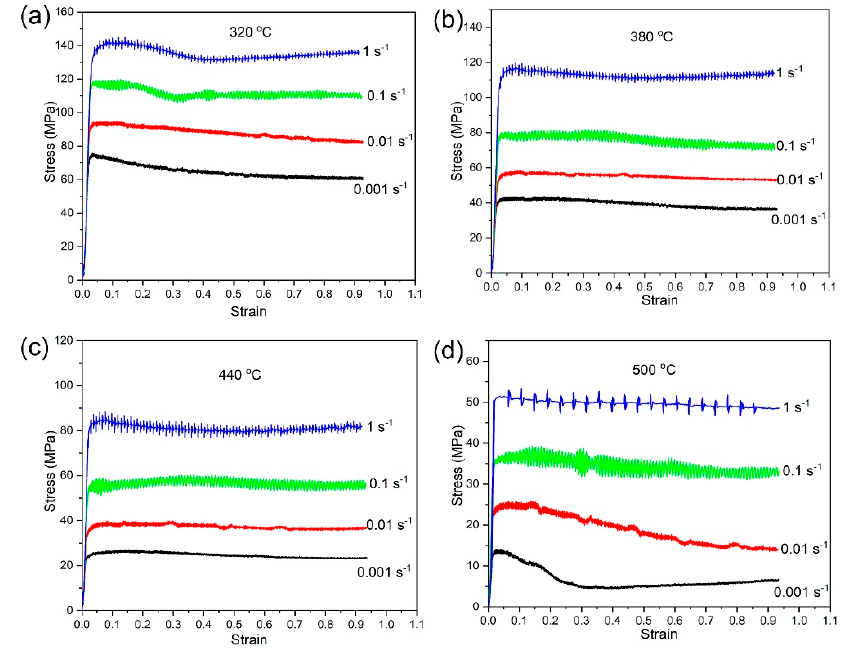
Figure 2. The flow curves of 2055 Al - Li alloy at temperature of ( a ) 320 °C, ( b ) 380 °C, ( c ) 440 °C and ( d ) 500 °C, with strain rates ranging from 0.001 s − 1 to 1 s − 1 . Reprinted from ref. [25].